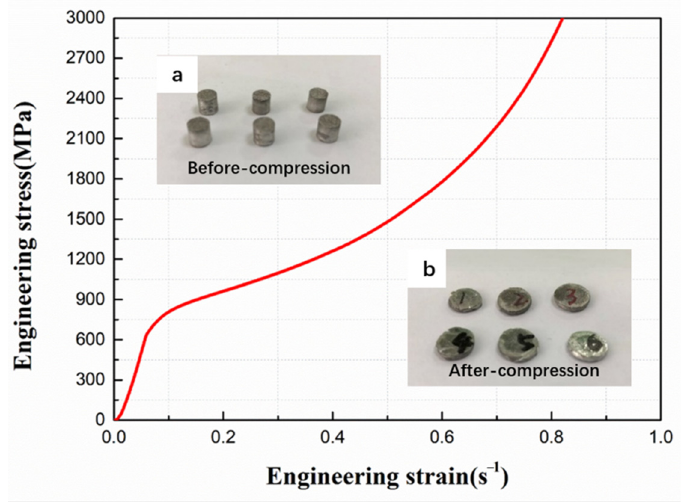
Figure 5. Representative stress–strain curves of AOEP specimens at a strain rate of 1 × 10 − 4 s − 1 . The inset figure is the specimens before and after quasi-static compression for ( a ) and ( b ), respectively.